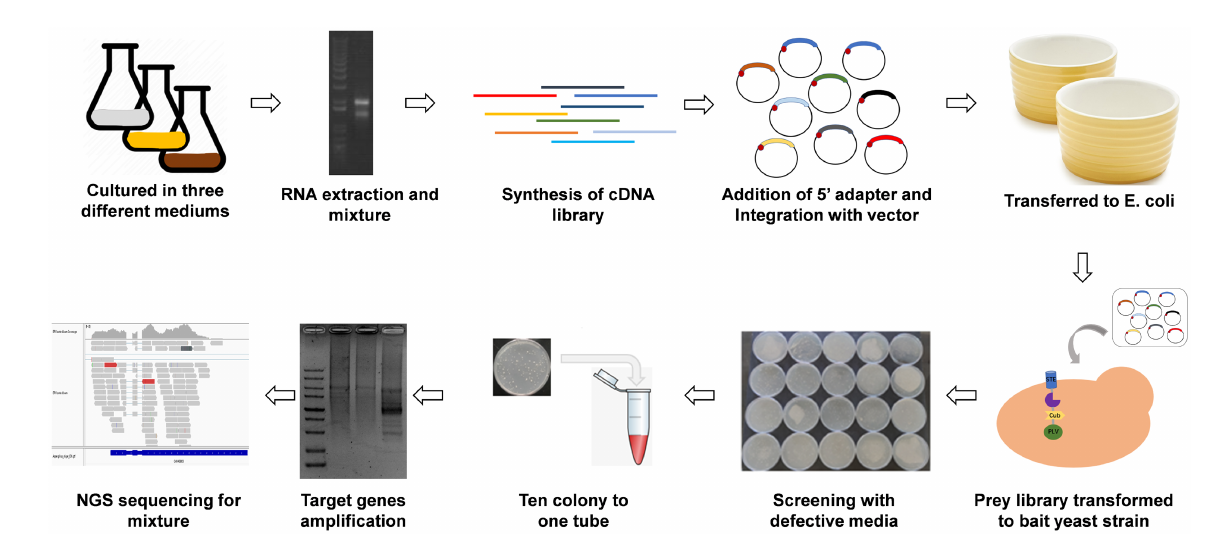
FIGURE 3 Workflow of the yeast two-hybrid combined with high throughput sequencing. RNA was extracted from A. niger cultured in three different media, then cDNA was synthesized and ligated to the prey vector after the addition of the adaptor. The prey library was transformed into the bait strain and then painted in amino acid-deficient media. For high-throughput screening, ten transformants were picked in one tube within 50 μ L ddH 2 O, which was used directly as a template for PCR. Then the target genes were amplified. Finally, all the PCR products were mixed for NGS